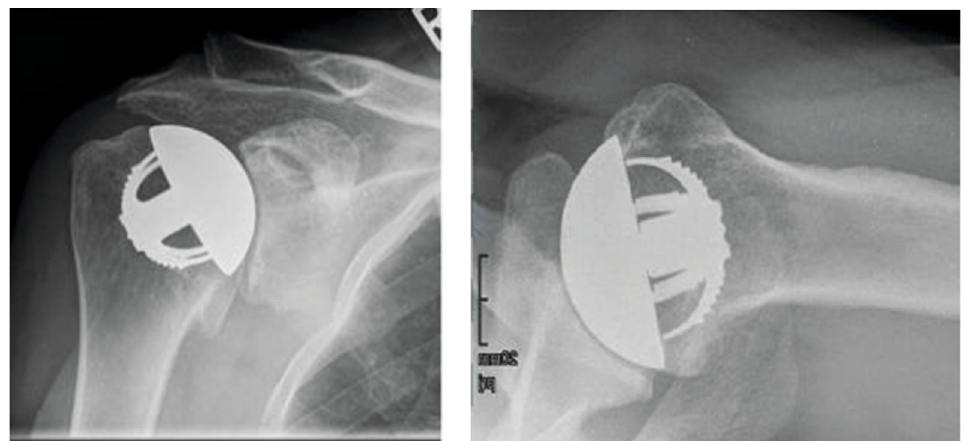
Figure 1: Preoperative X-ray, indwelling TESS anatomical stemless implant.